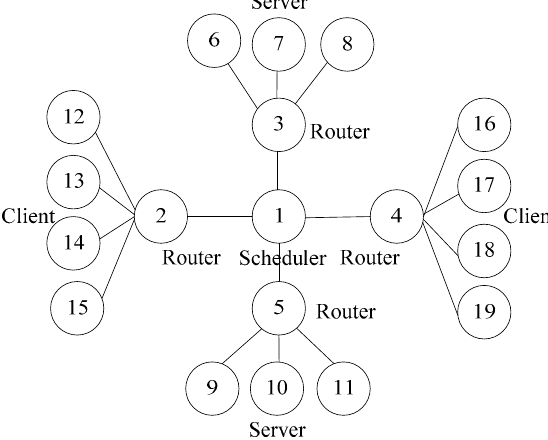
Figure 4. Topology diagram of the SWIM task scheduling simulation experiment.